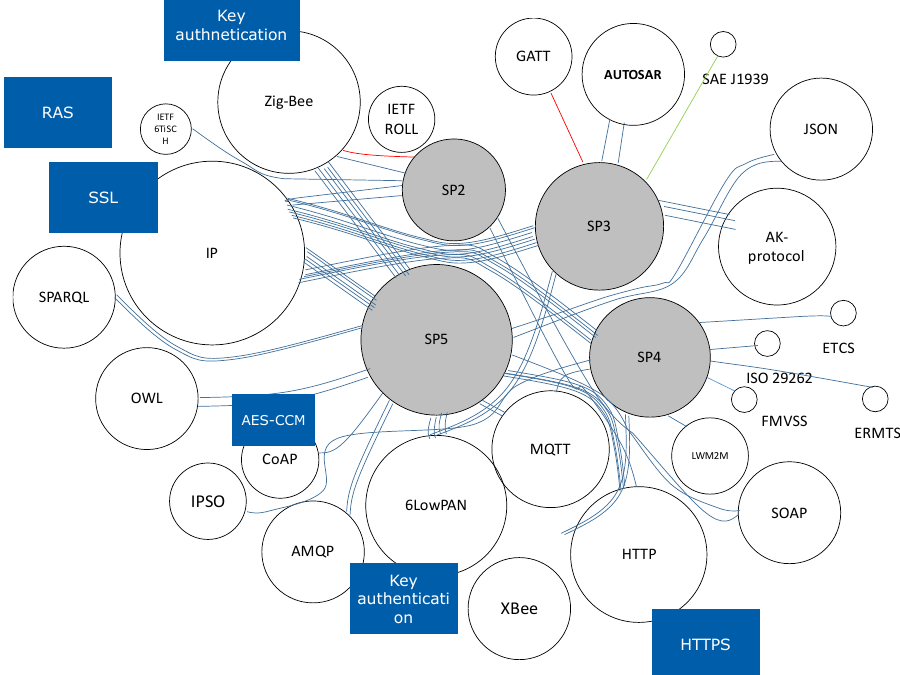
Figure 12. DEWI L2 upper layer technology standards. SP2-Aeronautics, SP3 Automotive, SP4 Railway, SP5